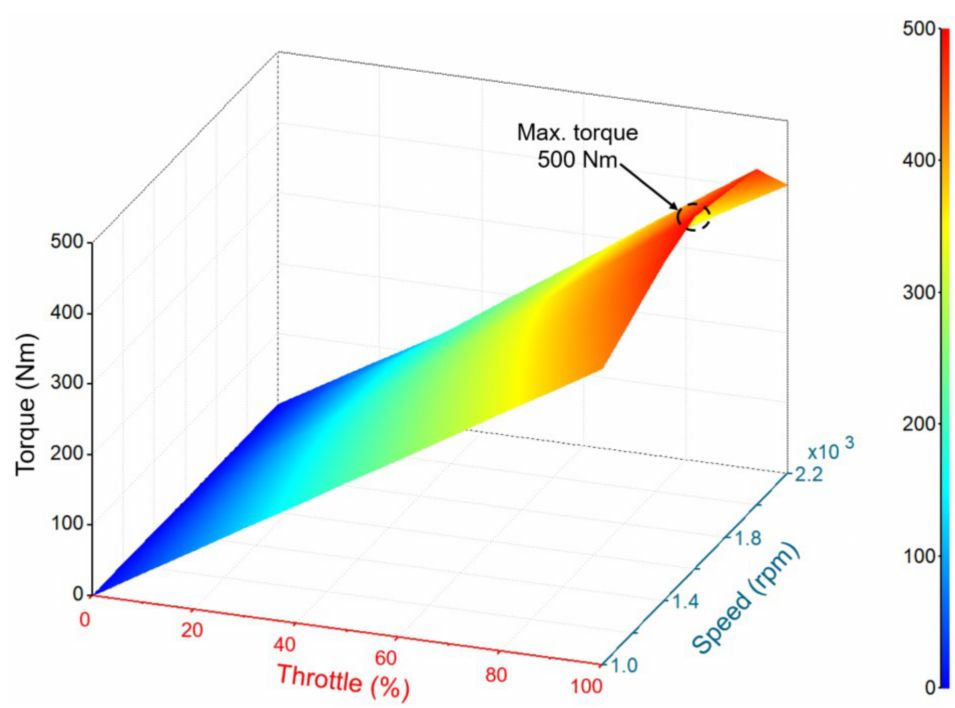
Figure 5. The 95 kW engine map used in this study.